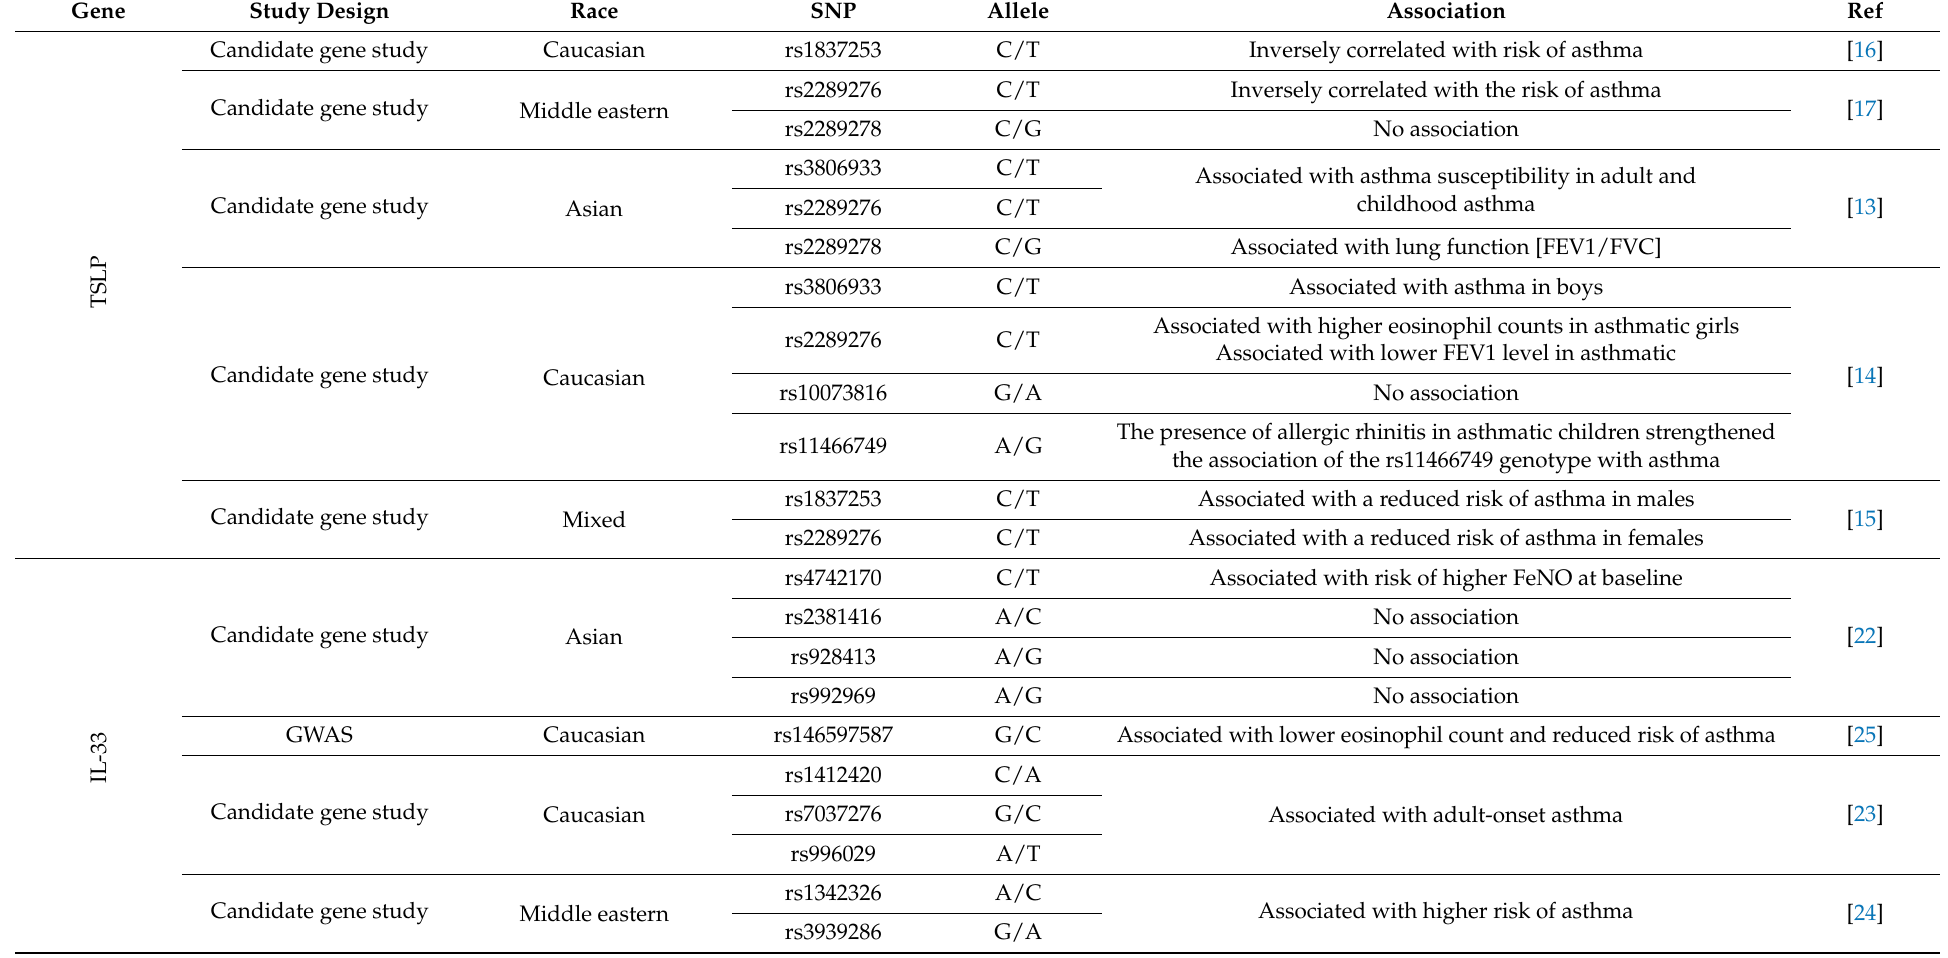
Table 1. Single nucleotide polymorphisms associated with asthma risk and